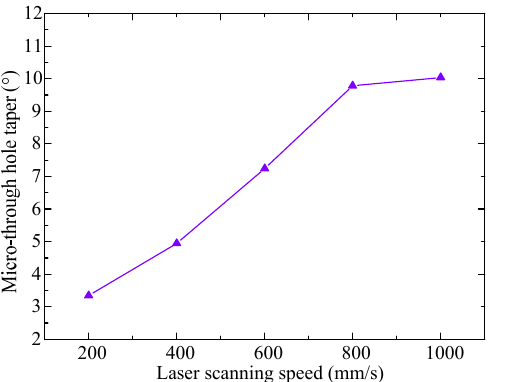
Figure 8. Effect of laser scanning speed on taper of micro-through-holes with the pulse energy of 12 μ J.